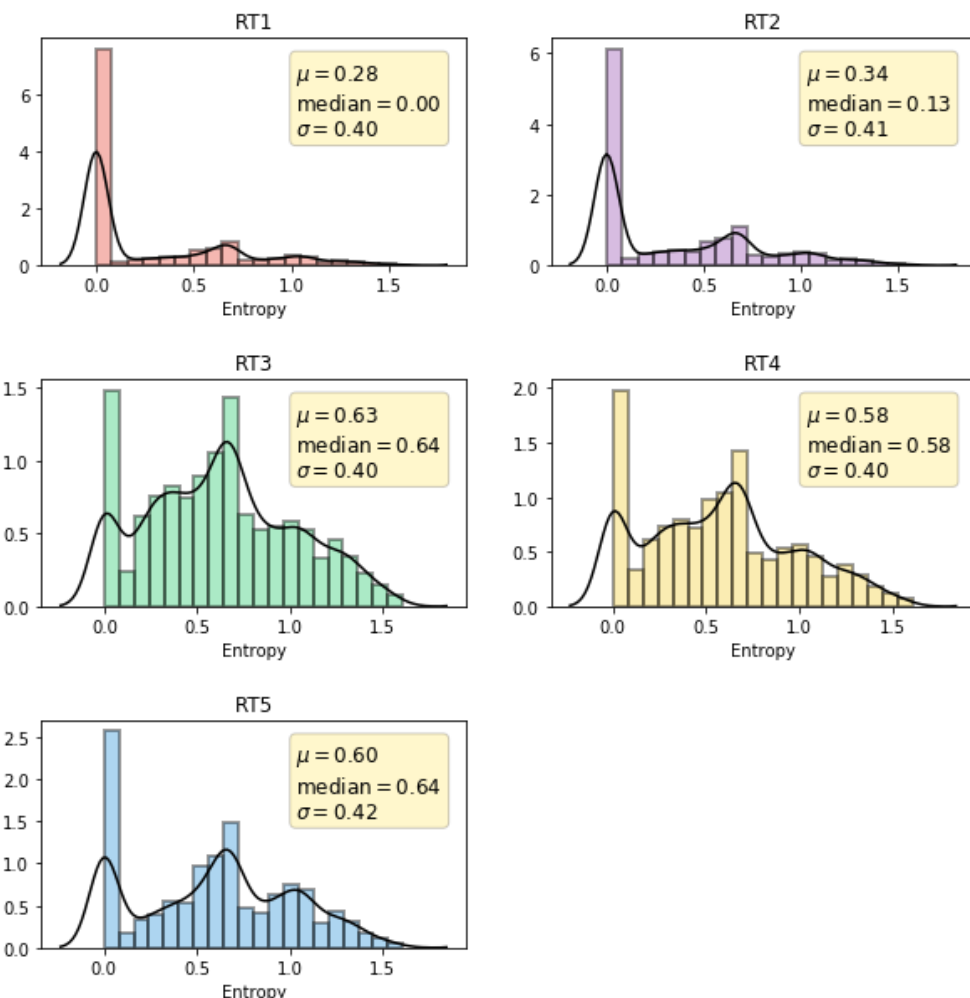
Figure 11. Distribution of the URL entropy for each community, fitted with a kernel density